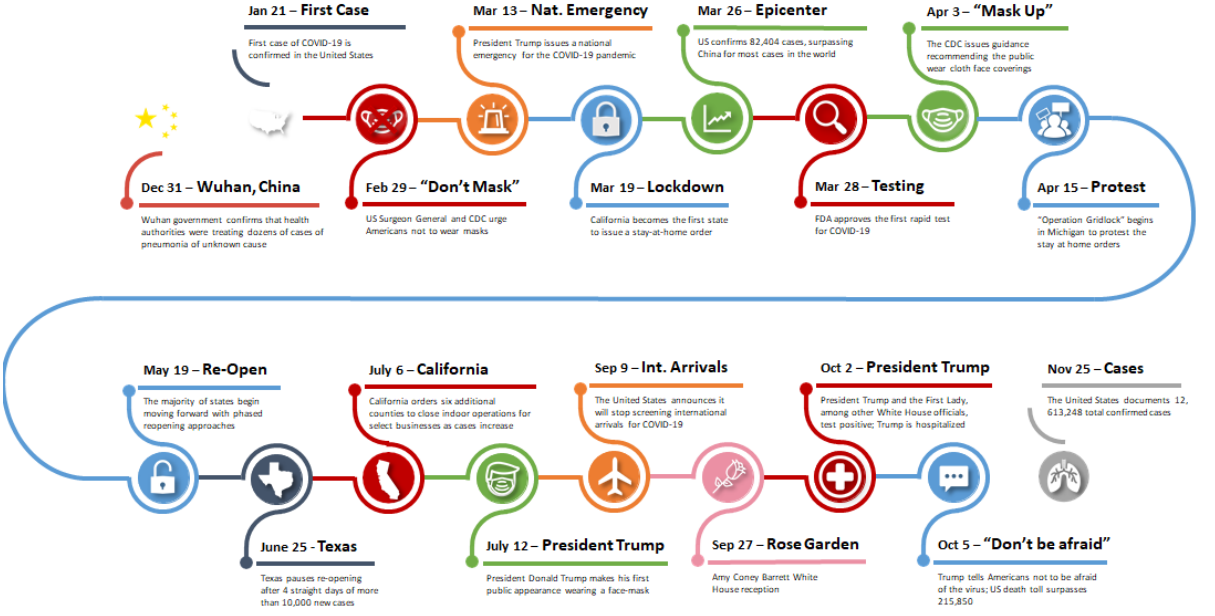
Figure 1. Timeline of COVID-19 in the United States. CDC: Centers for Disease Control and Prevention; FDA: Food and Drug